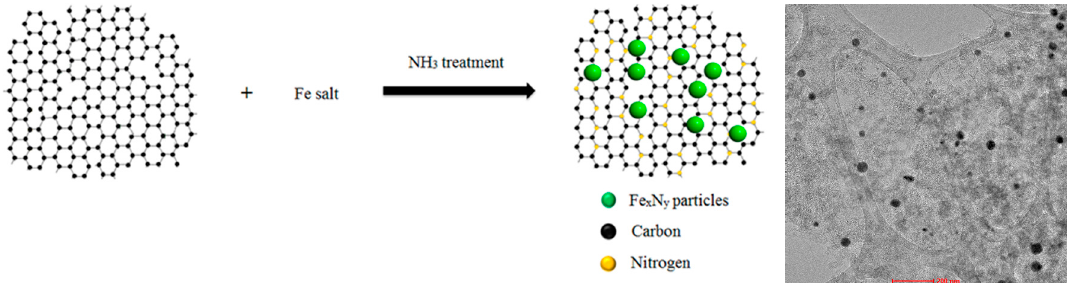
Scheme 1. Illustration of Fe x N y /nanocomposite (NC) synthesis.